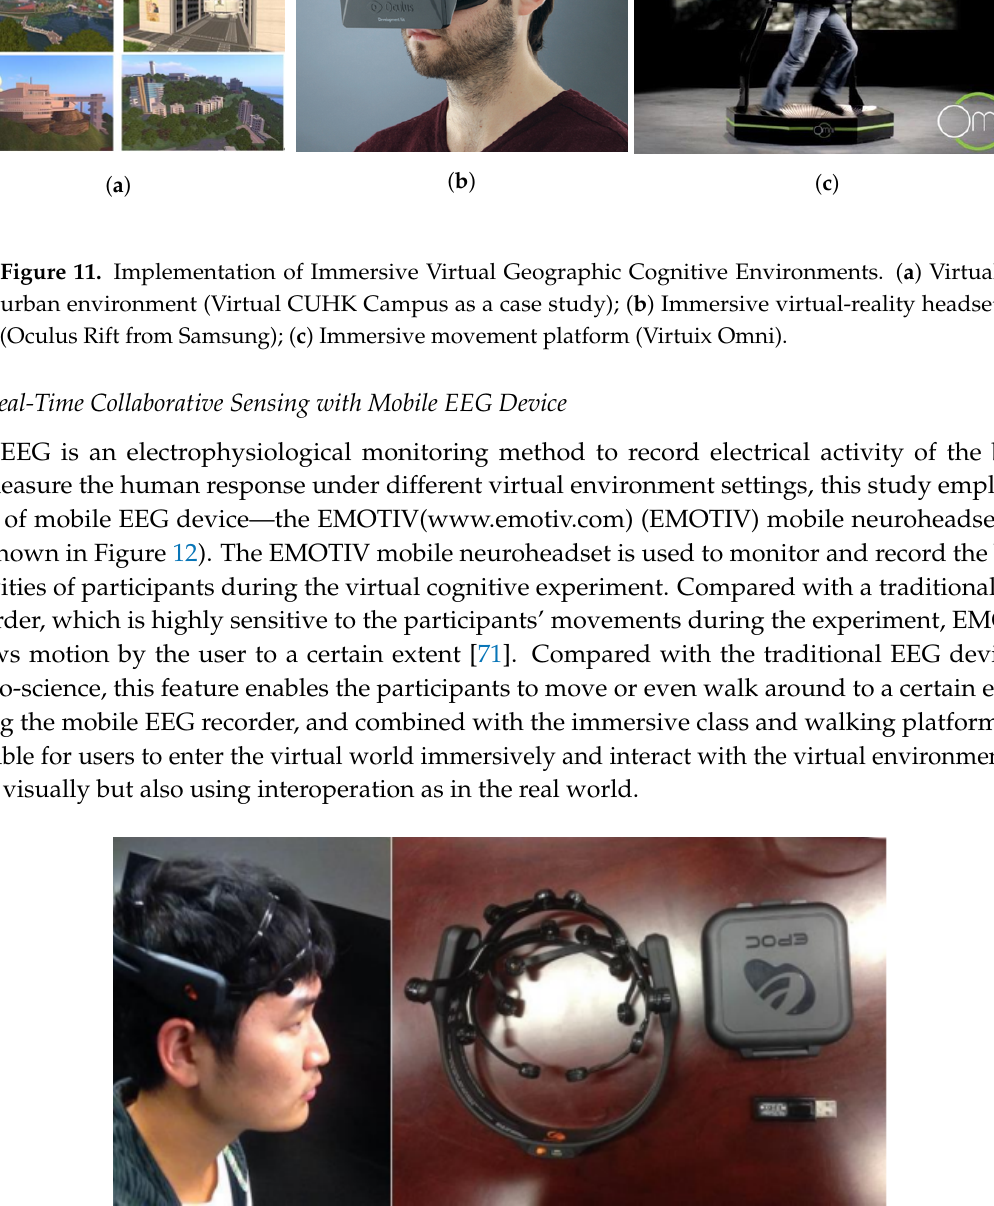
Figure 12. EMOTIV mobile neuroheadset for measuring an individual’s brain activities in virtual cognitive